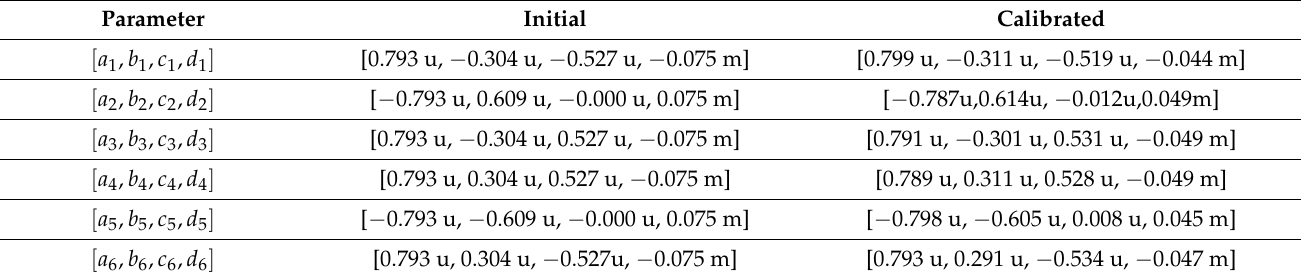
Table 3. The optimized parameters (planar reflectors’ coefficients); u: Unitless quantity; m: Meter; [ a , b , c ] : Unit vector of planar reflector; d : Distance of planar reflector to the origin. Parameter Initial